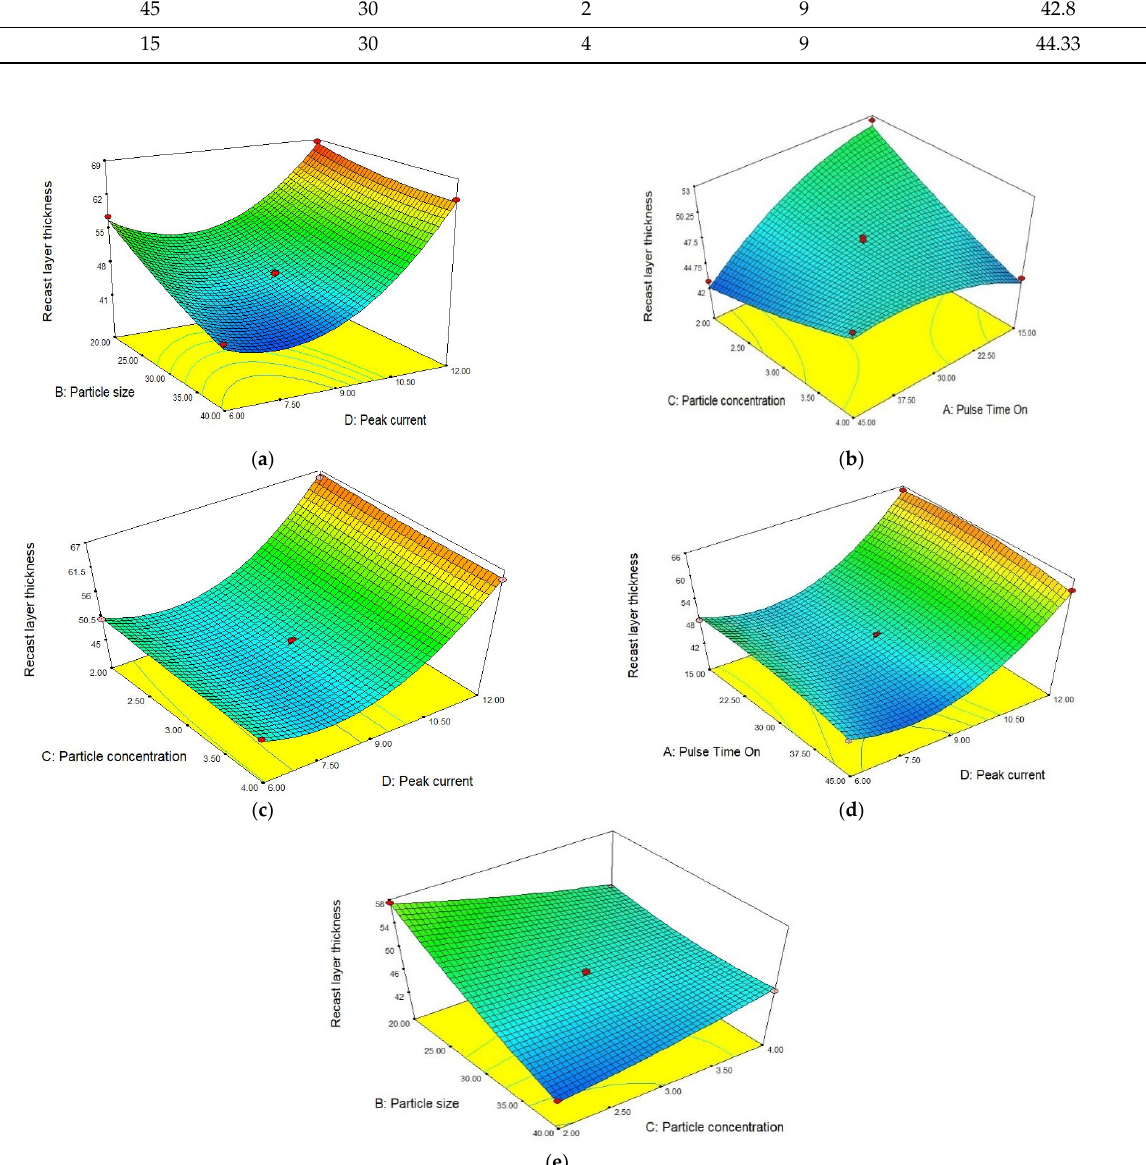
Figure 10. Effect of different parameters on RLT. ( a ) Peak current vs. particle size. ( b ) Pulse time on vs. particle concentration. ( c ) Particle concentration vs. peak current. ( d ) Peak current vs. pulse time on. ( e ) Particle size vs. particle concentration.